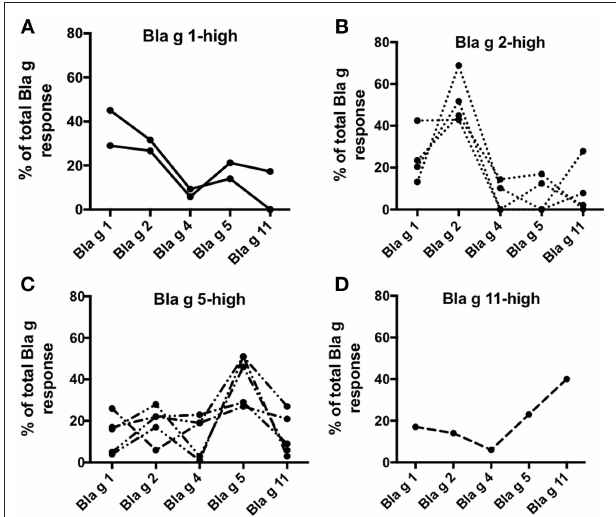
FIGURE 4 | Percent T cell reactivity to Bla g-derived peptide pools. Graphs showing T cell reactivity (sum of IL-5, IFN γ , and IL-10) in individual donors against each Bla g component peptide pool as percent of the sum of all Bla g pools. Donors are grouped based on their predominant T cell reactivity for (A) Bla g 1, (B) Bla g 2, (C) Bla g 5, and (D) Bla g 11. N =